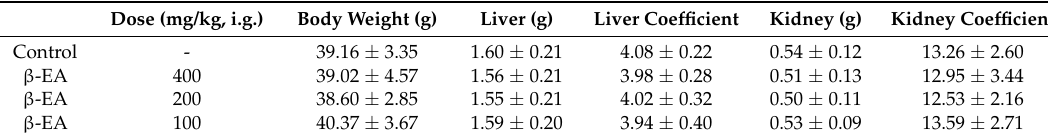
Table 1. Effects of repeated administration of β -EA on visceral coefficients in mice treated for four weeks (mean ± SD, n = 10).